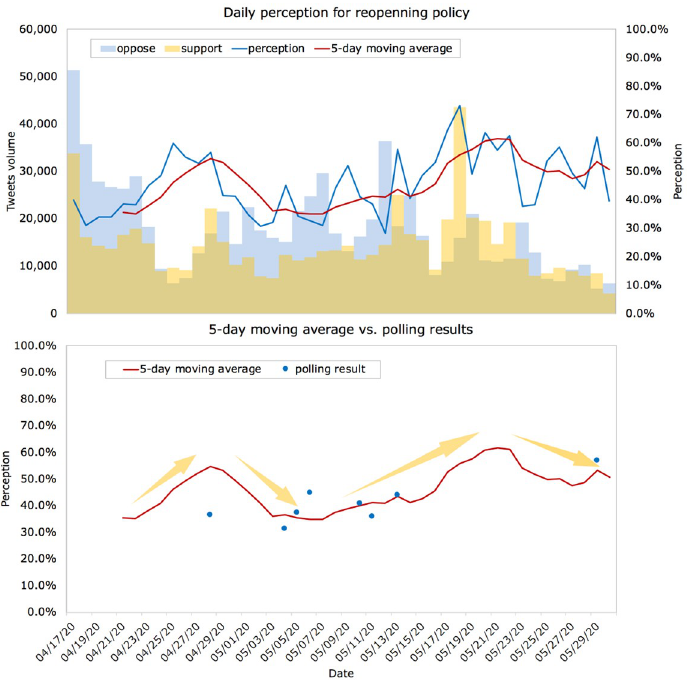
Fig 2. Daily perception and moving average. a. Daily perception and 5-day moving average for supporting reopening from April 17 to May 30, 2020. A perception < 0.5 indicates that more online users opposed reopening, while a perception > 0.5 implies that the majority supported reopening. The absolute volume of tweets indicating supporting reopening or opposing reopening is also presented. b. Comparison between the 5-day moving average perception with national polling